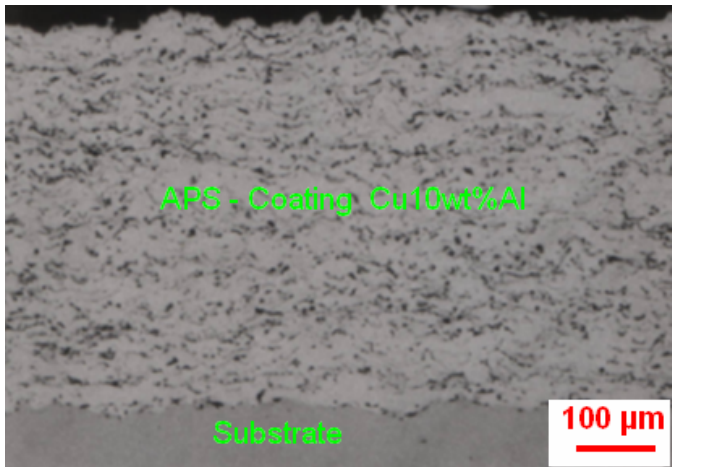
Figure 2 – (OM) Cu10wt.%Al coating microstructure Рис . 2 – ( ОМ ) Микроструктура Cu10 вес .%Al покрытия